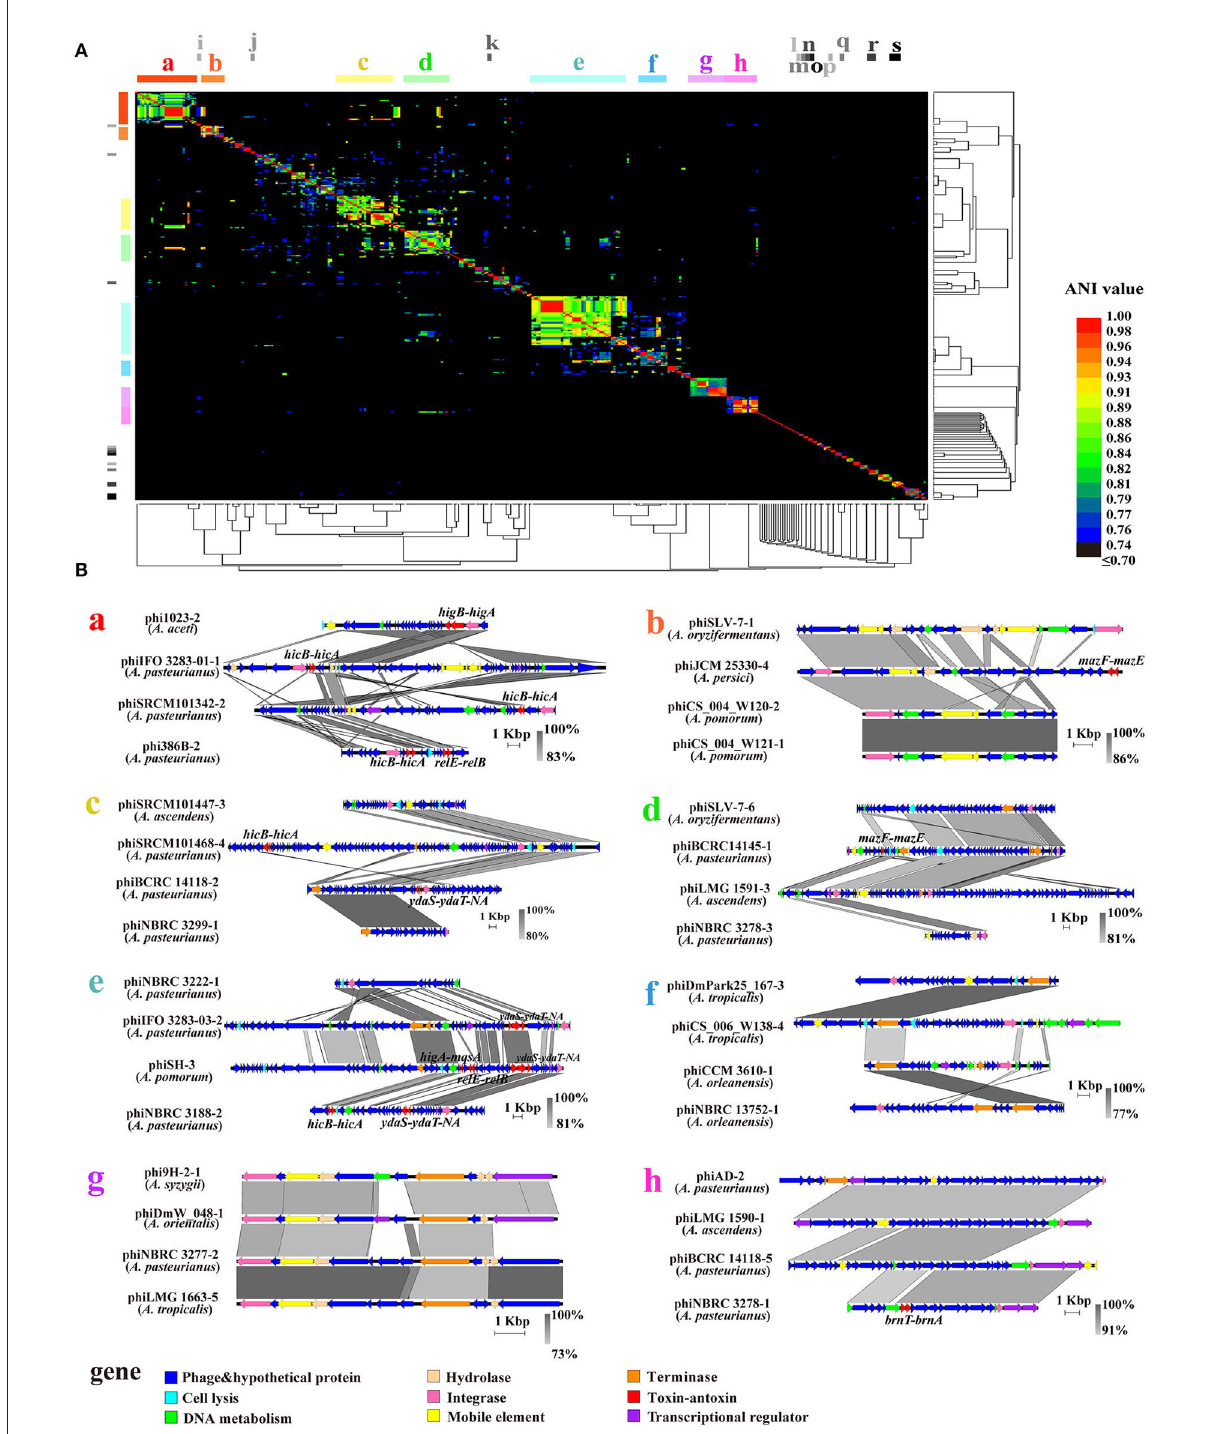
FIGURE3 Analysis of 350 active prophage genomes. (A) The 350 prophage paired ANI values were clustered using a mean linkage hierarchical clustering method based on Pearson’s distance for rows and columns in all clusters. The colors in the heat map represent different ANI values, gradually changing from blue (low identity) to red (high identity). a to h’ represent the eight large subclusters and i to s’ represent the small subclusters composed of prophages of a single Acetobacter species. The ANI values are shown in Supplementary Table S3. (B) Comparative genomics of prophages for each large subcluster 8 (a, b, c, d, e, f, g, and h). The gray area represents the similarity module and the similarity changes gradually from gray (low) to black